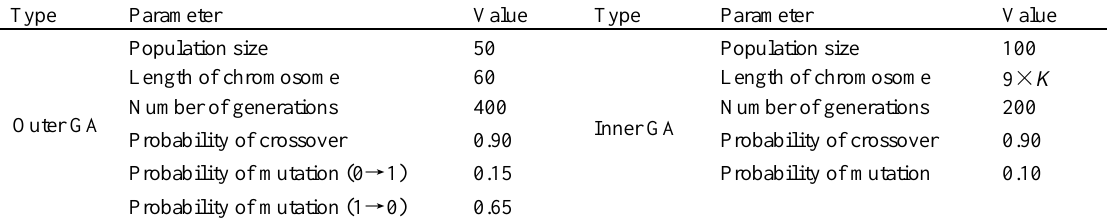
Table 2. Parameters list of the bilevel genetic algorithm